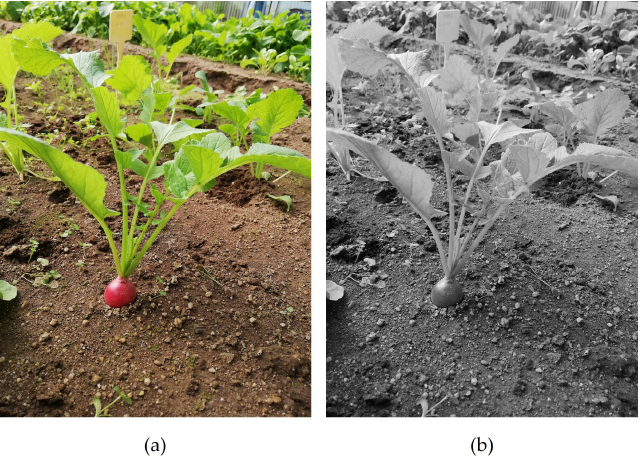
Figure 1. Radish image acquired in RGB colour space ( a ) and after greyscale transformation ( b